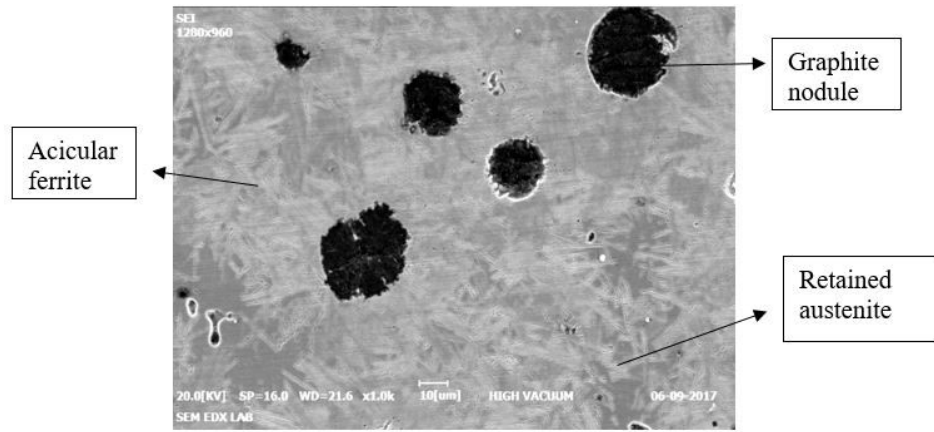
Figure 1. SEM image of ADI austenitized at 950ºC and austempered at 320ºC with 0.64 wt% Mn.